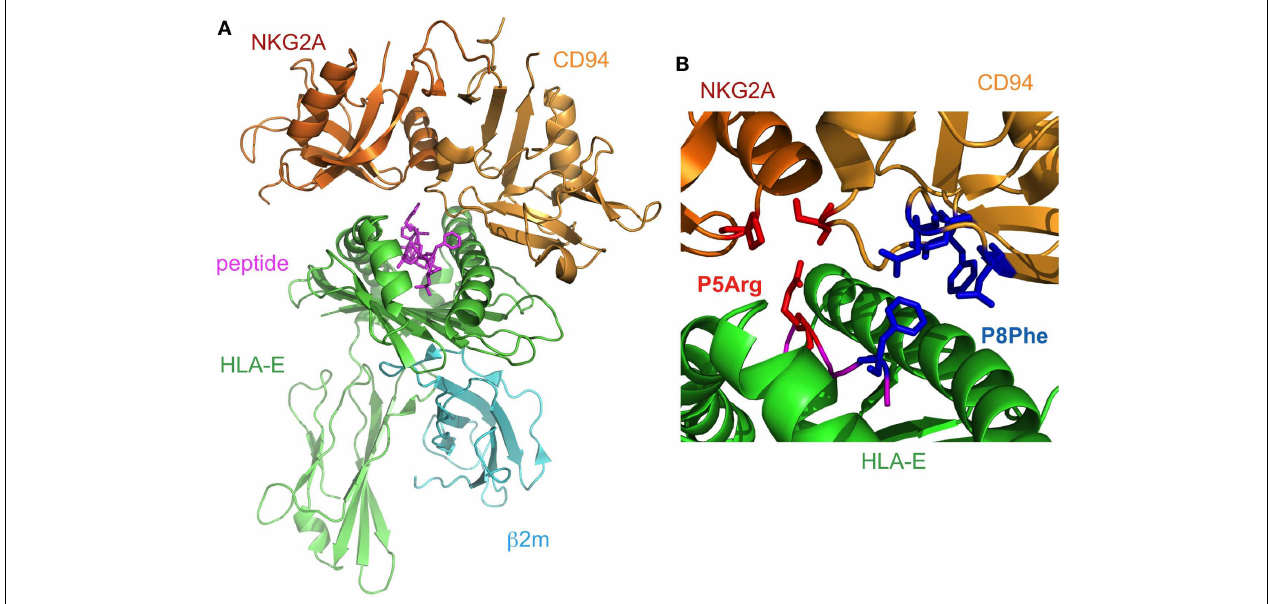
FIGURE 5 |The complex structure of NKG2A/CD94 and HLA-E. (A) The overall structure of the NKG2A/CD94/HLA-E complex (PDB ID: 3CDG). NKG2A/CD94 recognizes the α 1– α 2 domain of HLA-E containing a peptide.